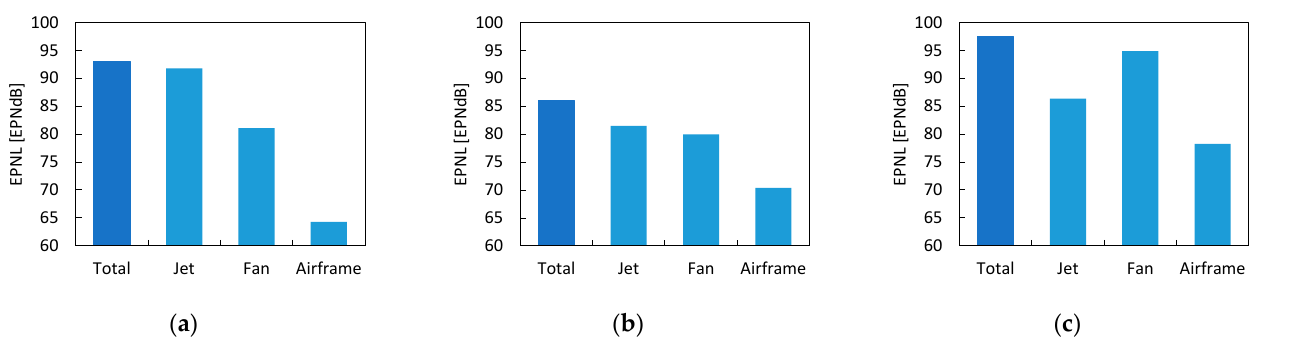
Figure 10. Predicted component noise: ( a ) lateral measurement point; ( b ) flyover measurement point; and ( c ) approach measurement point.